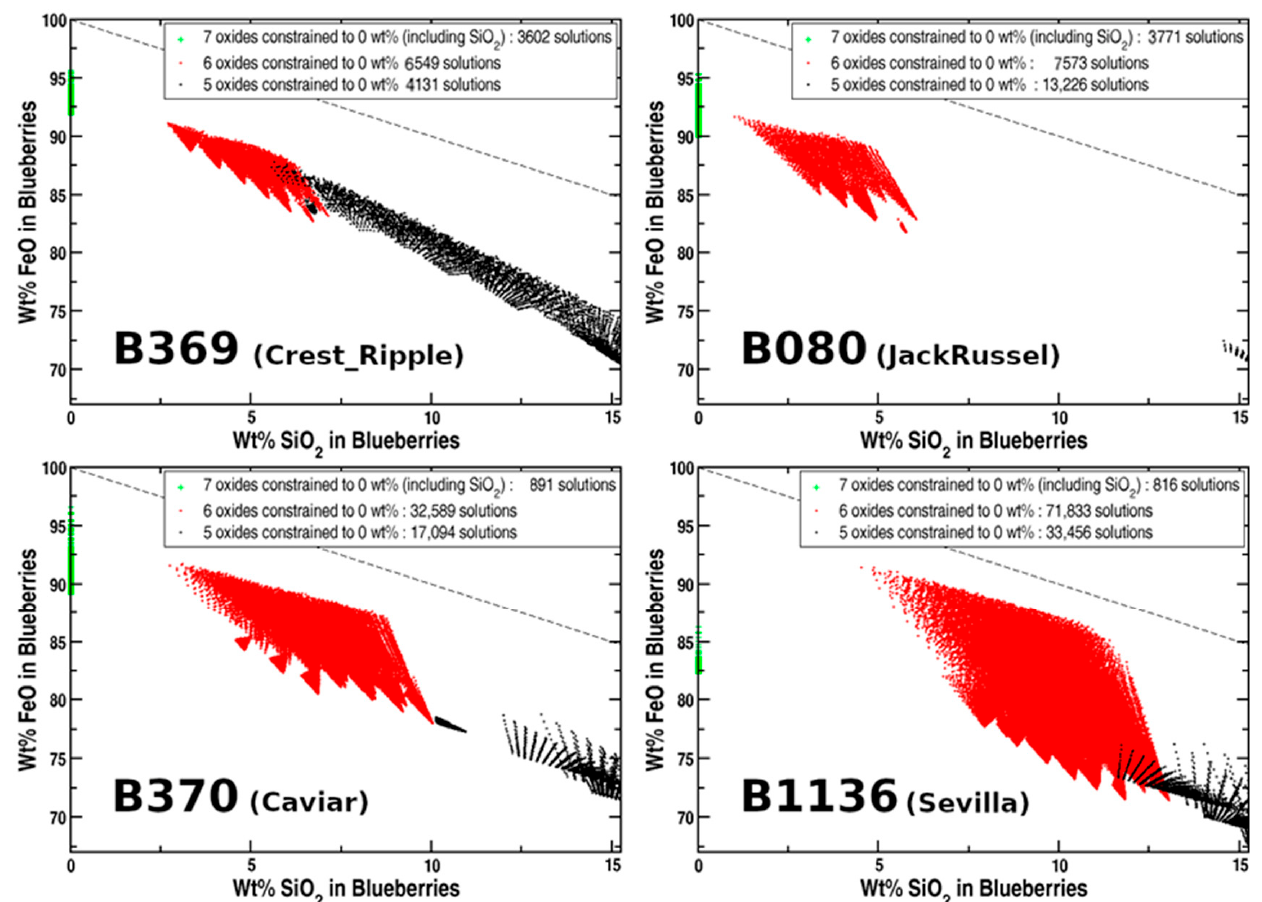
Figure 2. FeO verses SiO 2 blueberry weight percentage scatter plots. The scatter plots in Figure 2 only reach SiO 2 weight percentages of 15 wt%. However, other complete set solutions had higher SiO 2 weight percentages and lower FeO weight percentages. These solution sets, with higher blueberry SiO 2 content, were computed using constraint sets where either two, three, four, or (sometimes) five of the oxides were constrained to 0 wt%. The scatter plot continuations to higher SiO 2 weight percentages produce straight extended bands. The FeO and SiO 2 weight percentages are strongly anti-correlated with Pearson coefficients between − 0.9 and − 1.0. The complete solutions sets with higher (above 15 wt%) SiO 2 content in blueberries were not consistent with the Mini-TES instrument’s non-detection of silicate minerals in